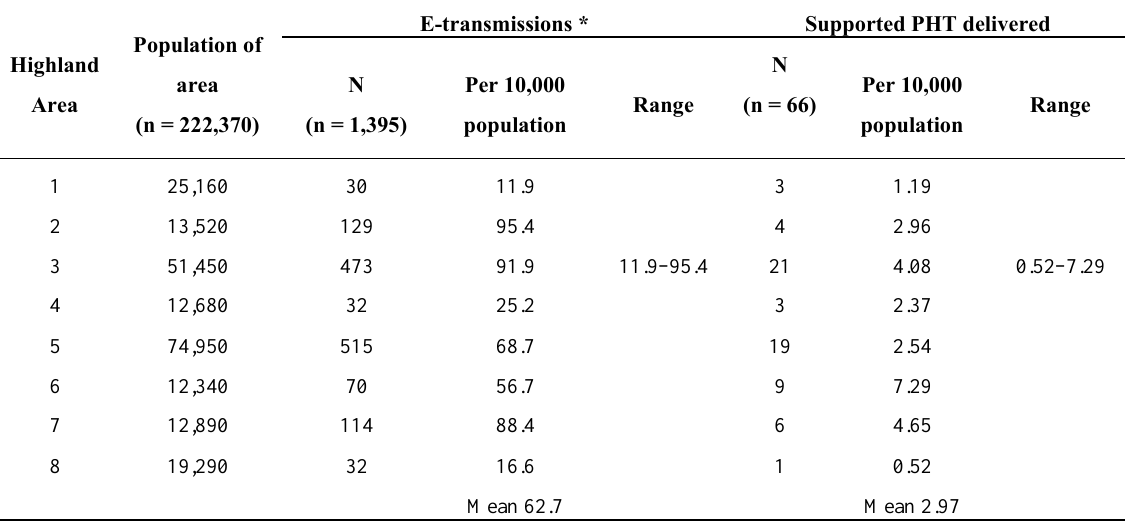
Table 4. E-transmissions and PHT by area (population figures as National Records of Scotland mid-year estimates 2011: [22]).